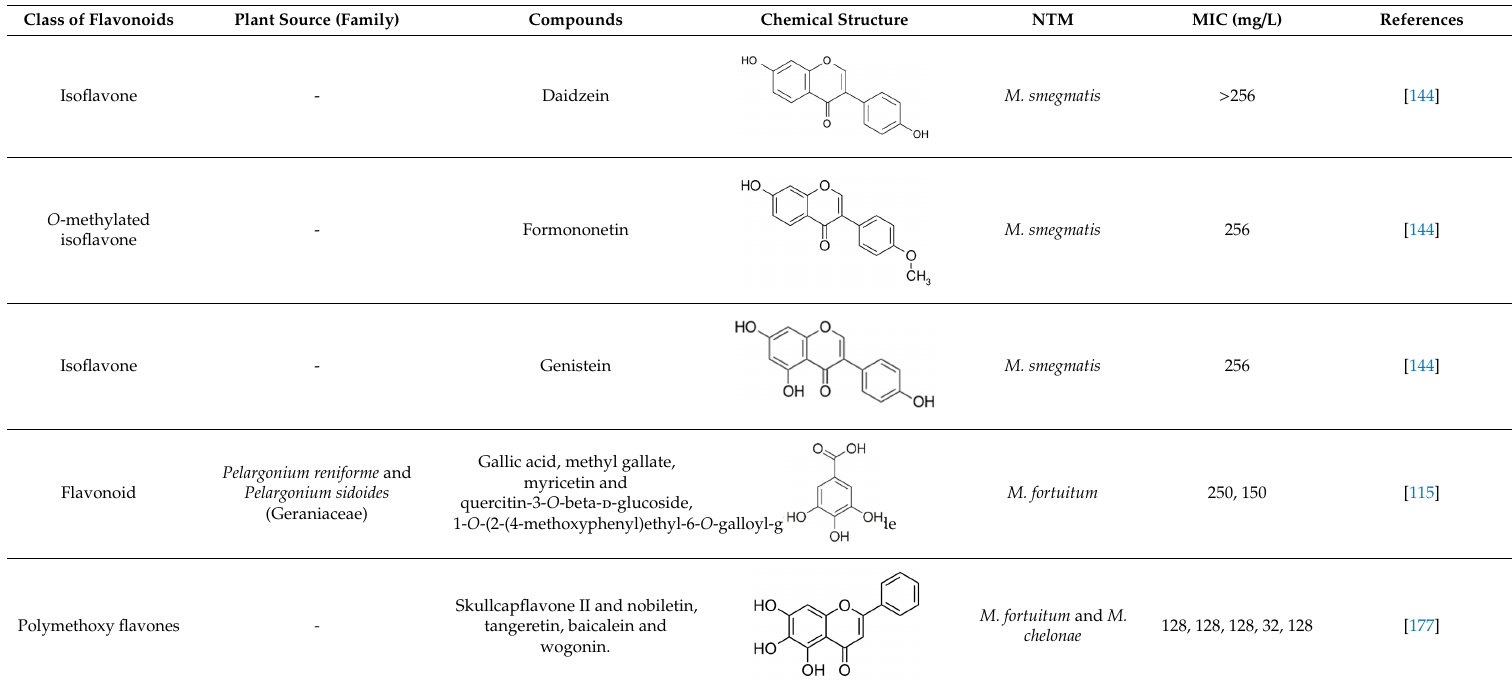
Skullcapflavone II and nobiletin, tangeretin, baicalein and